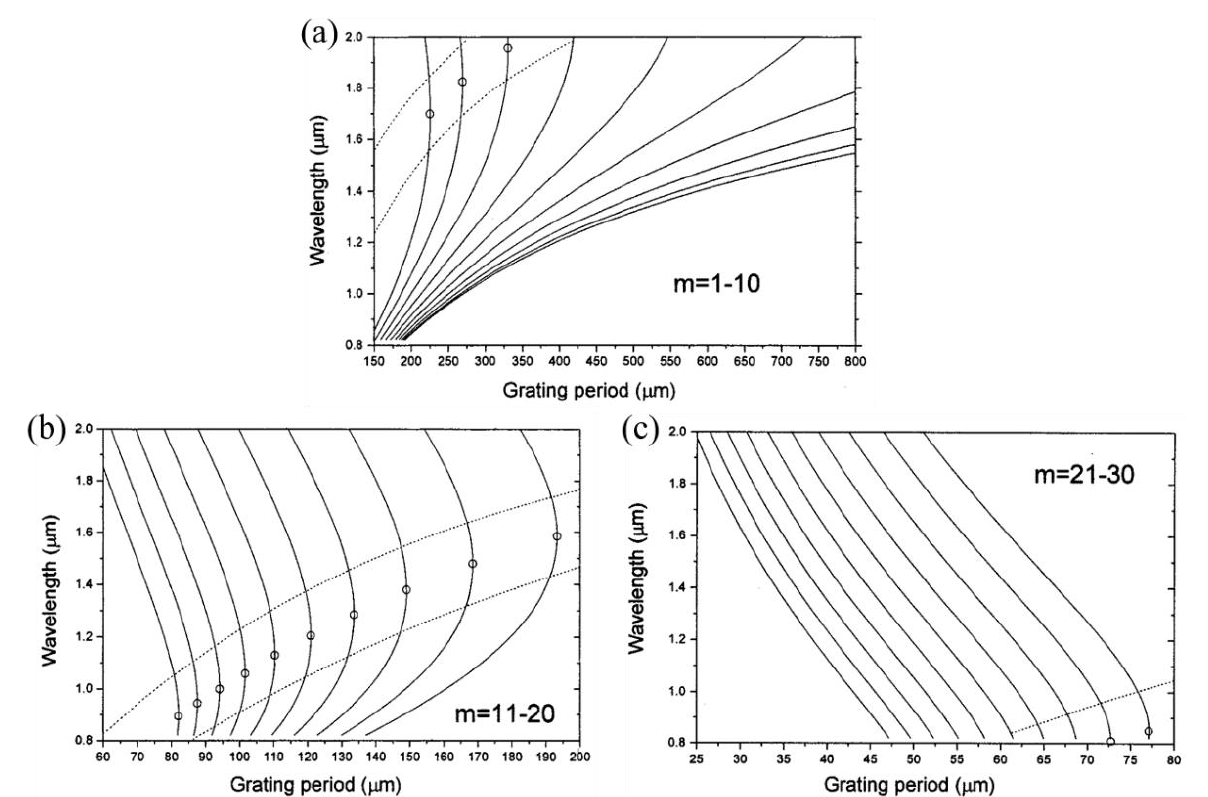
Figure 3. Calculated variation of mode resonance wavelength with LPFG period. ( a ) Modes m = 1 to m = 10. ( b ) Modes m = 11 to m = 20. ( c ) Modes m = 21 to m = 30. The small circles locate the turning points of the slopes of the curves, and the LPFG exhibits greatest sensitivity in the region between the two dotted lines. Adopted with from [18]. Under a Creative Commons license.